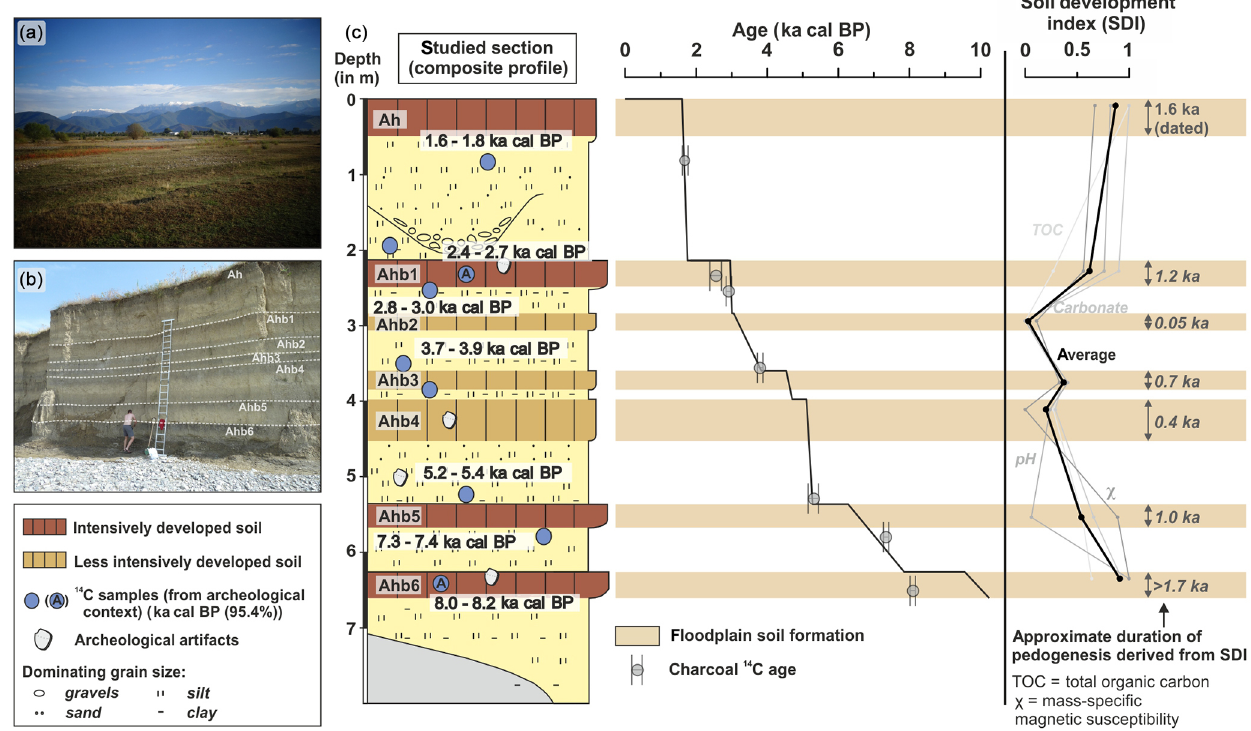
Figure 3. (a) Photo of the active modern floodplain next to the investigated FSPS in the front and the mountainous upper Alazani catchment in the southern Greater Caucasus in the back. (b) Photo of the investigated FSPS with highlighted (paleo)soils. (c) Schematic stratigraphy of the investigated FSPS (left) with the age–depth model based on 14 C datings of charcoal pieces (center) and approximate durations of soil formation based on a soil development index (SDI) (right; von Suchodoletz et al., 2018). The two charcoal samples that overestimated their burial ages were excluded from the age–depth model. Charcoal 14 C ages are given as calibrated age ranges in kacalBP (95.4%) with the calibrated median